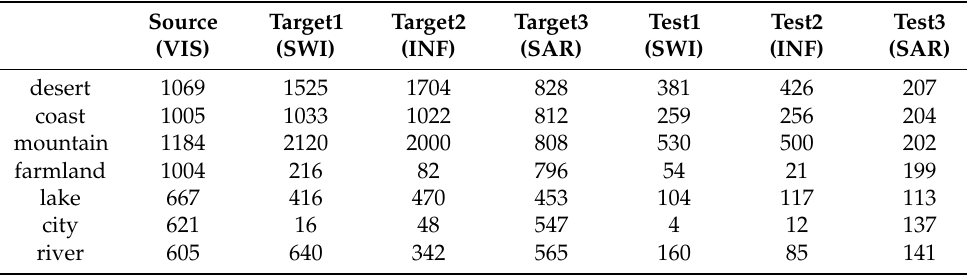
Table 1. Division of MRSSC2.0